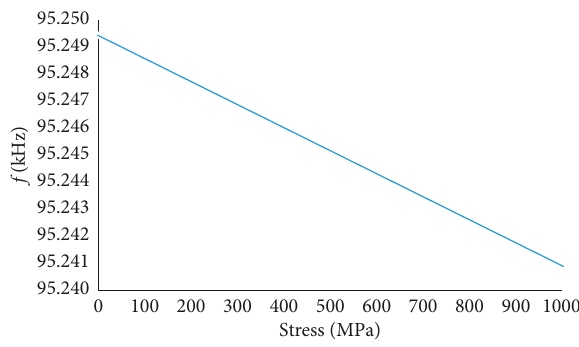
Figure 5: Relationship diagram between frequency and